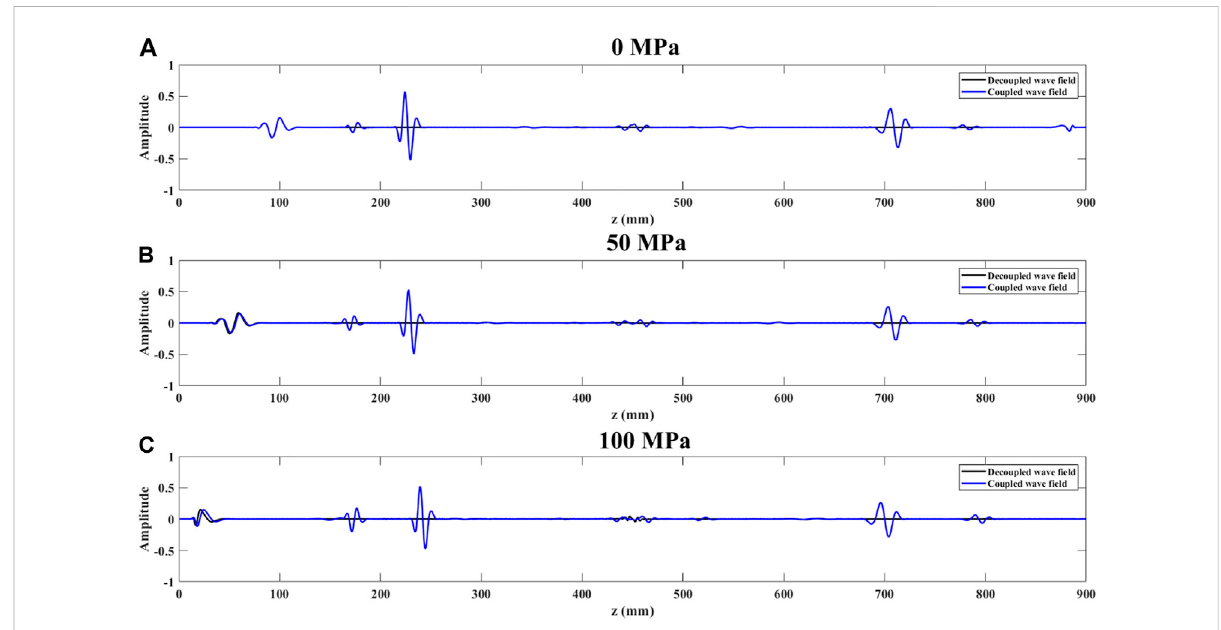
FIGURE 24 Recordsof x =300 mminsnapshotsaboveforvariouspureshearstresses( (A) :0MPa; (B) :50MPa; (C) :100MPa).(Bluedottedlineisarecordof coupled wave fi eld; Black line is a record of decoupled P-wave fi